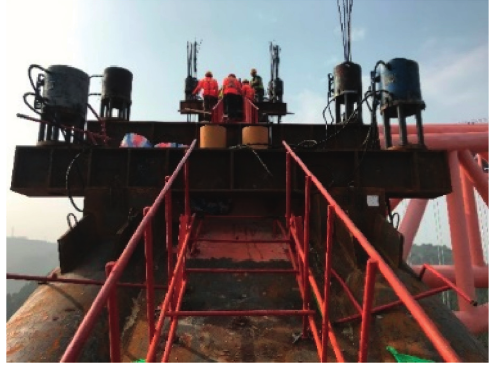
Figure 14: Temporary system above the arch